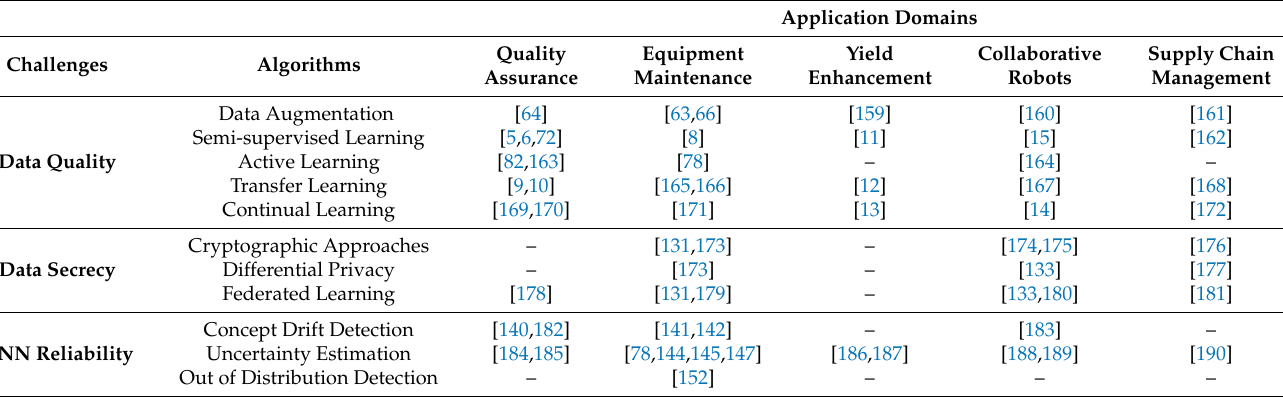
Table 4. Summary of deep learning algorithms and their industrial